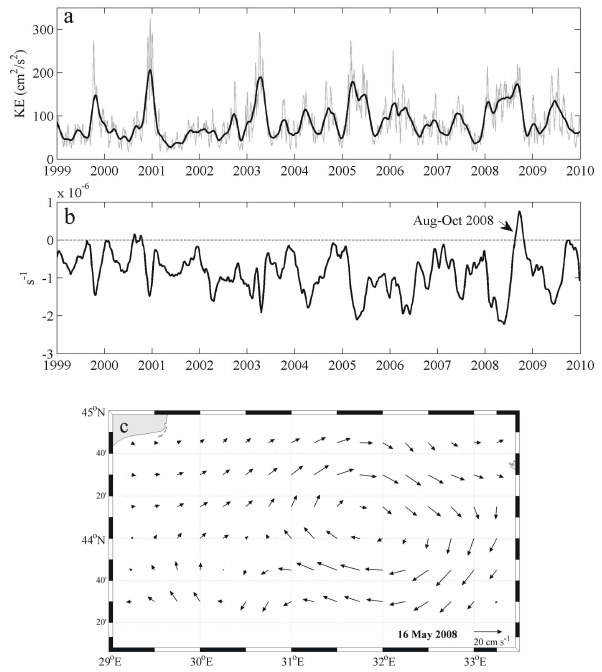
Fig. 7. (a) Time series of KE spatially averaged in the region of SE (43.75–44.75 ◦ N, 30–33 ◦ E); grey line represents the daily time series while the black line is the 90day moving average of KE. (b) Time series of the spatially averaged relative vorticity of the surface geostrophic currents in the region of SE; black arrow indi- cate the period characterised by cyclonic circulation. (c) Snapshot of geostrophic currents ( U G ) in the region of